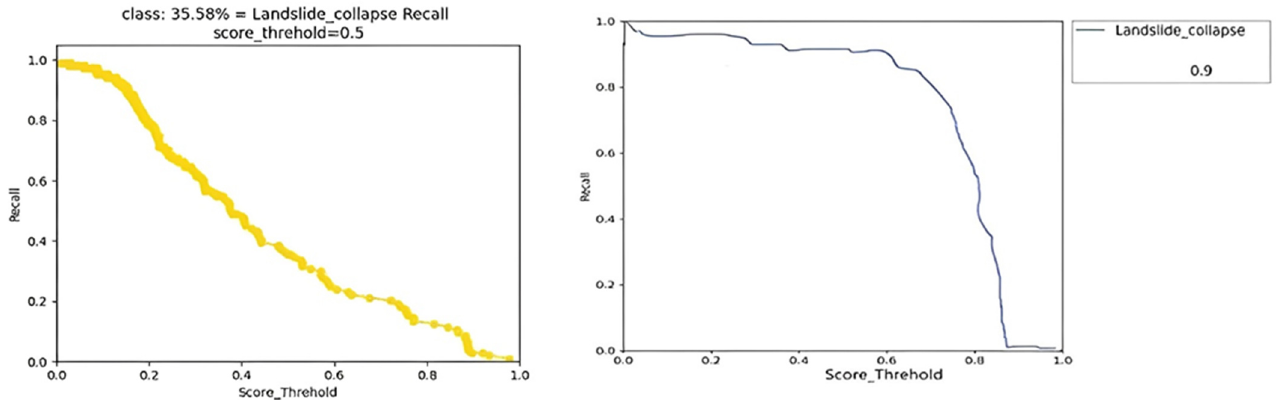
Figure 13. The P–R Curve of the SSD model ( left ) and the transfer learning model ( right ). 4.3.4. F1-Score The F1 score is the harmonic mean of recall and precision, which is a more compre- hensive evaluation index. Values above 0.6 are considered satisfactory. The calculation formula is as follows: F1 = 2 ∗ 𝑝𝑟𝑒𝑐𝑖𝑠𝑖𝑜𝑛 ∗ 𝑟𝑒𝑐𝑎𝑙𝑙 𝑝𝑟𝑒𝑐𝑖𝑠𝑖𝑜𝑛 + 𝑟𝑒𝑐𝑎𝑙𝑙